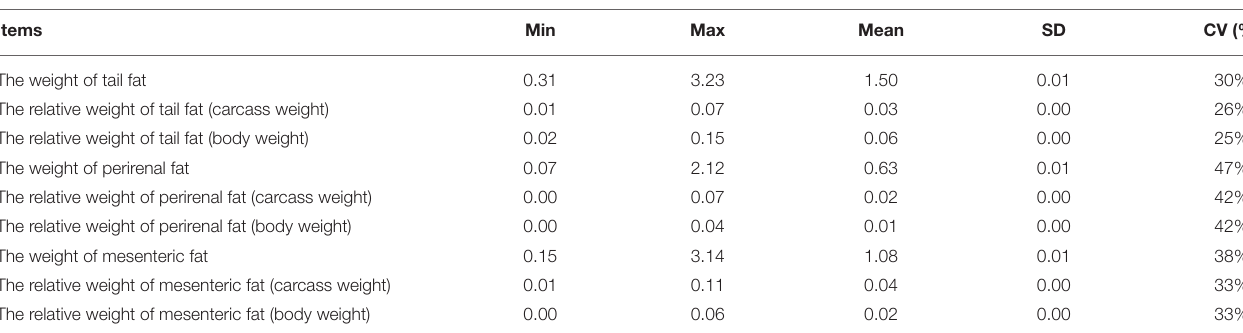
TABLE 4 | Descriptive statistics of fat traits.